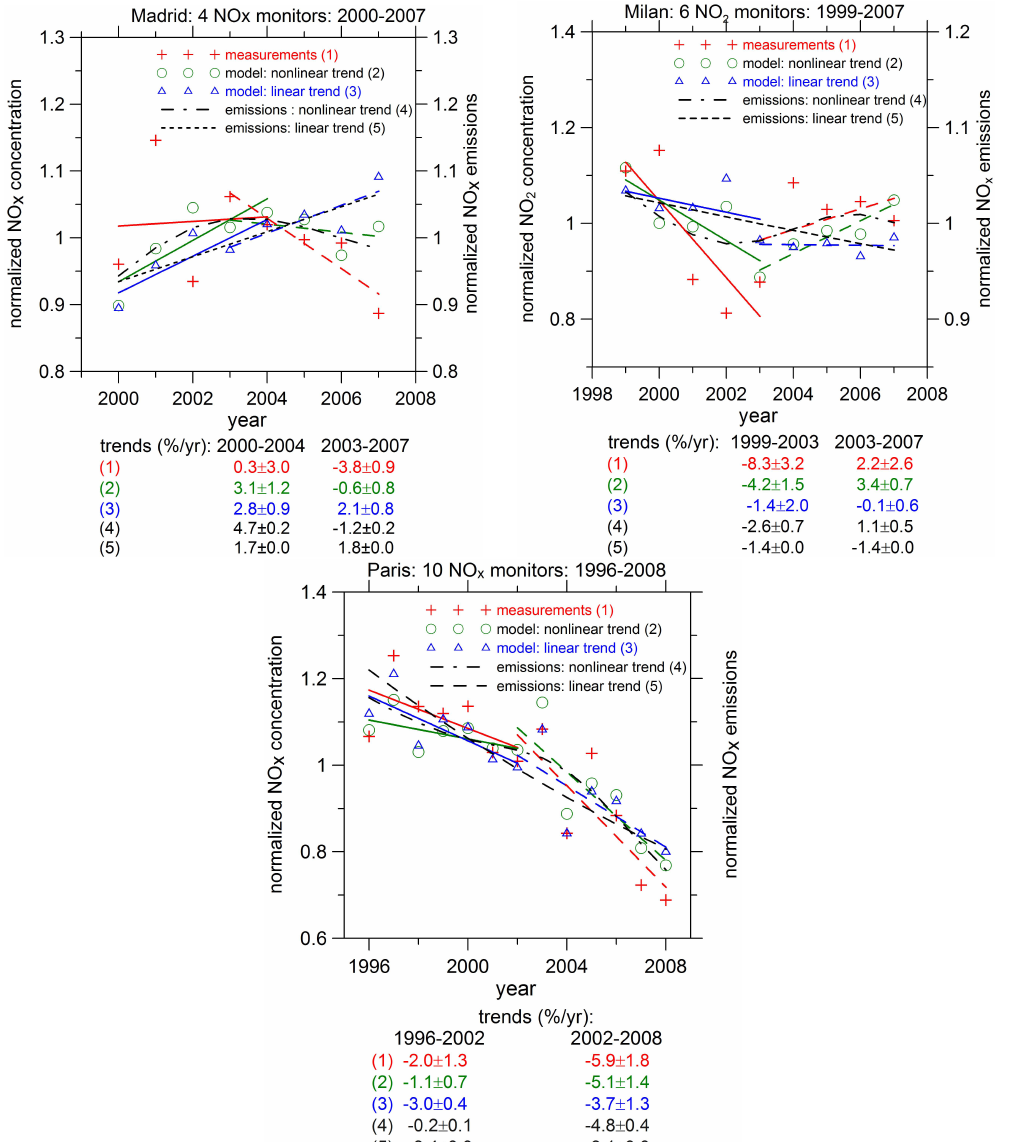
Fig. 10. Comparison of (1) air quality monitoring data with simulations based on (2) nonlinear and (3) linear trends of NO x emission estimates derived from satellite measurements. The nonlinear (4) and linear (5) NO x emission trends used in simulations are also shown. The reported uncertainties of the piece-wise linear trends are evaluated as the standard deviation of the slope of the corresponding linear fits.